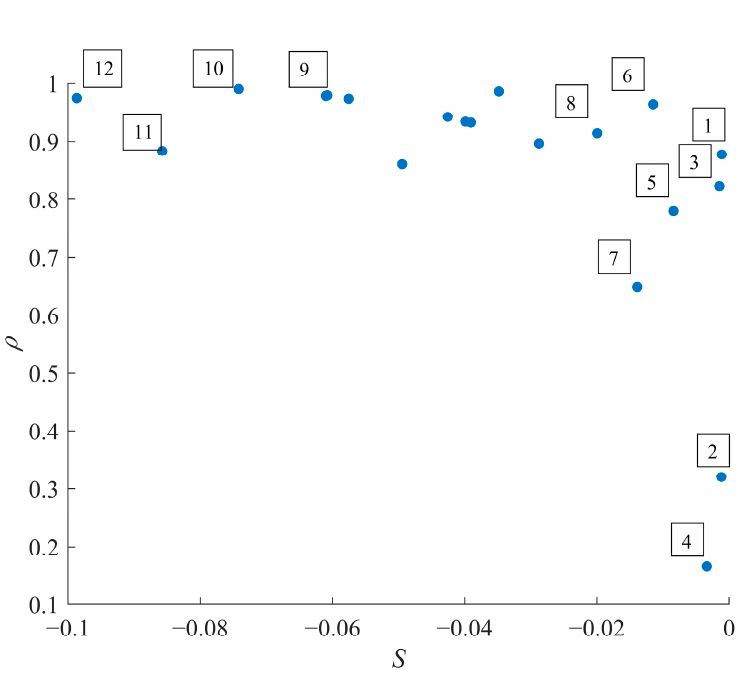
Figure 12. The distribution of shape entropies ( S ) and ρ from Equation (1) of different small bodies. No. 1–12 can be referred in Table 5, and their shapes are shown in Figures 13–15.